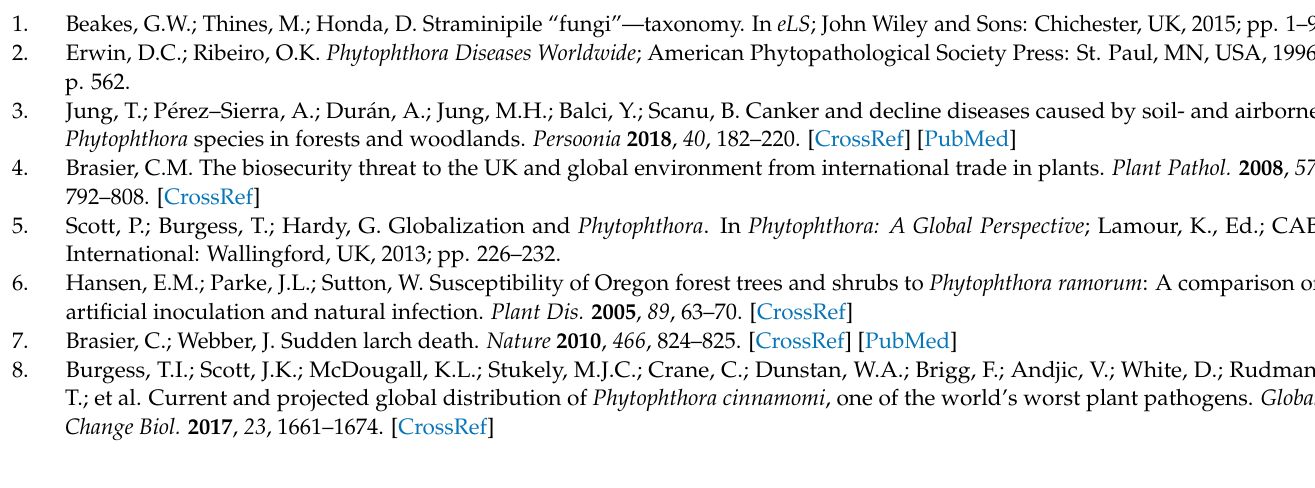
Figure S2: The Walter and Lieth climate diagram for the experimental field plot for the year 2017 distinguishes dry (yellow) and humid (blue) periods. Temperature (red line) refers to the average monthly mean temperature, and precipitation (blue line) refers to the average monthly precipitation. Daily averages of hourly recorded soil water potential (SWP, black line) and precipitation (blue columns) are displayed in the bottom of the figure. Both annual average air temperature and precipitation total are as indicated in the